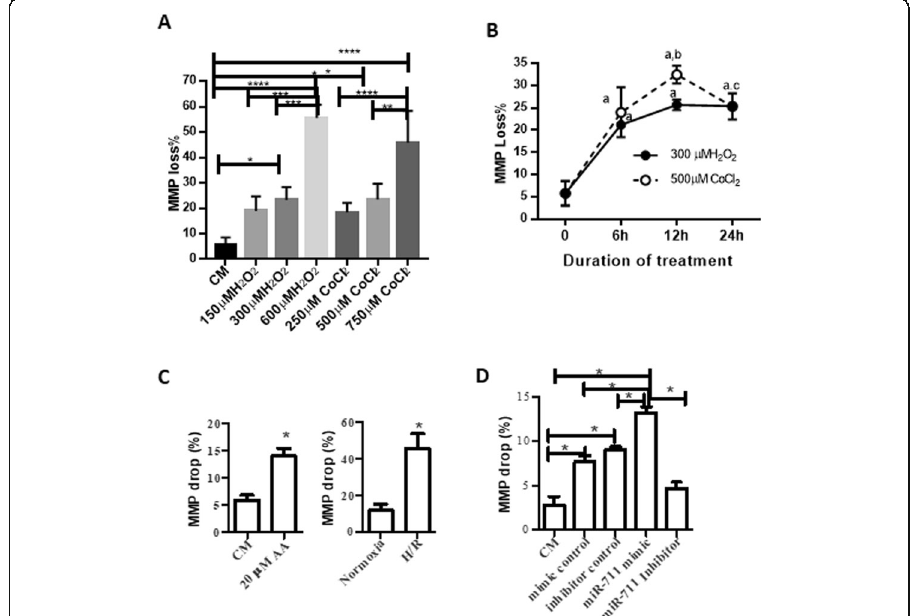
Fig. 3 Inhibition of miR-711 reduced oxidative stress-mediated mitochondrial damage. a Treatment with H 2 O 2 and CoCl 2 decreased the MMP. Cells were treated with H 2 O 2 and CoCl 2 as described in Fig. 1a. Mitochondrial damage was assessed by measuring the MMP by staining cells with green fluorescent DiOC6, followed by flow cytometry. b The effect of treatment duration on the MMP. Cells were treated with 300 μ M H 2 O 2 and 500 μ M CoCl 2 for the indicated hours, respectively. The MMPs were detected as in ( a ). c AA and H/R decreased the MMP. Cells were treated 20 μ M AA or exposed to cold H/R. The MMPs were detected as in ( a ). d Over-expression of miR-711 increased mitochondrial damage. H9c2 cells were transfected with 1 μ g of miR-711 mimic or inhibitors for 48 h prior to H/R. 24 h after reoxygenation, the MMPs were measured by flow cytometry. n = 3, * P < 0.05, ** P < 0.01, *** P < 0.001, **** P < 0.0001. a: treatment groups compared with cells cultured in DMEM-CM; b: treatment with 500 μ M CoCl 2 for 12 h compared with treatment for 6 h; c: Treatment with 500 μ M CoCl 2 for 24 h compared with